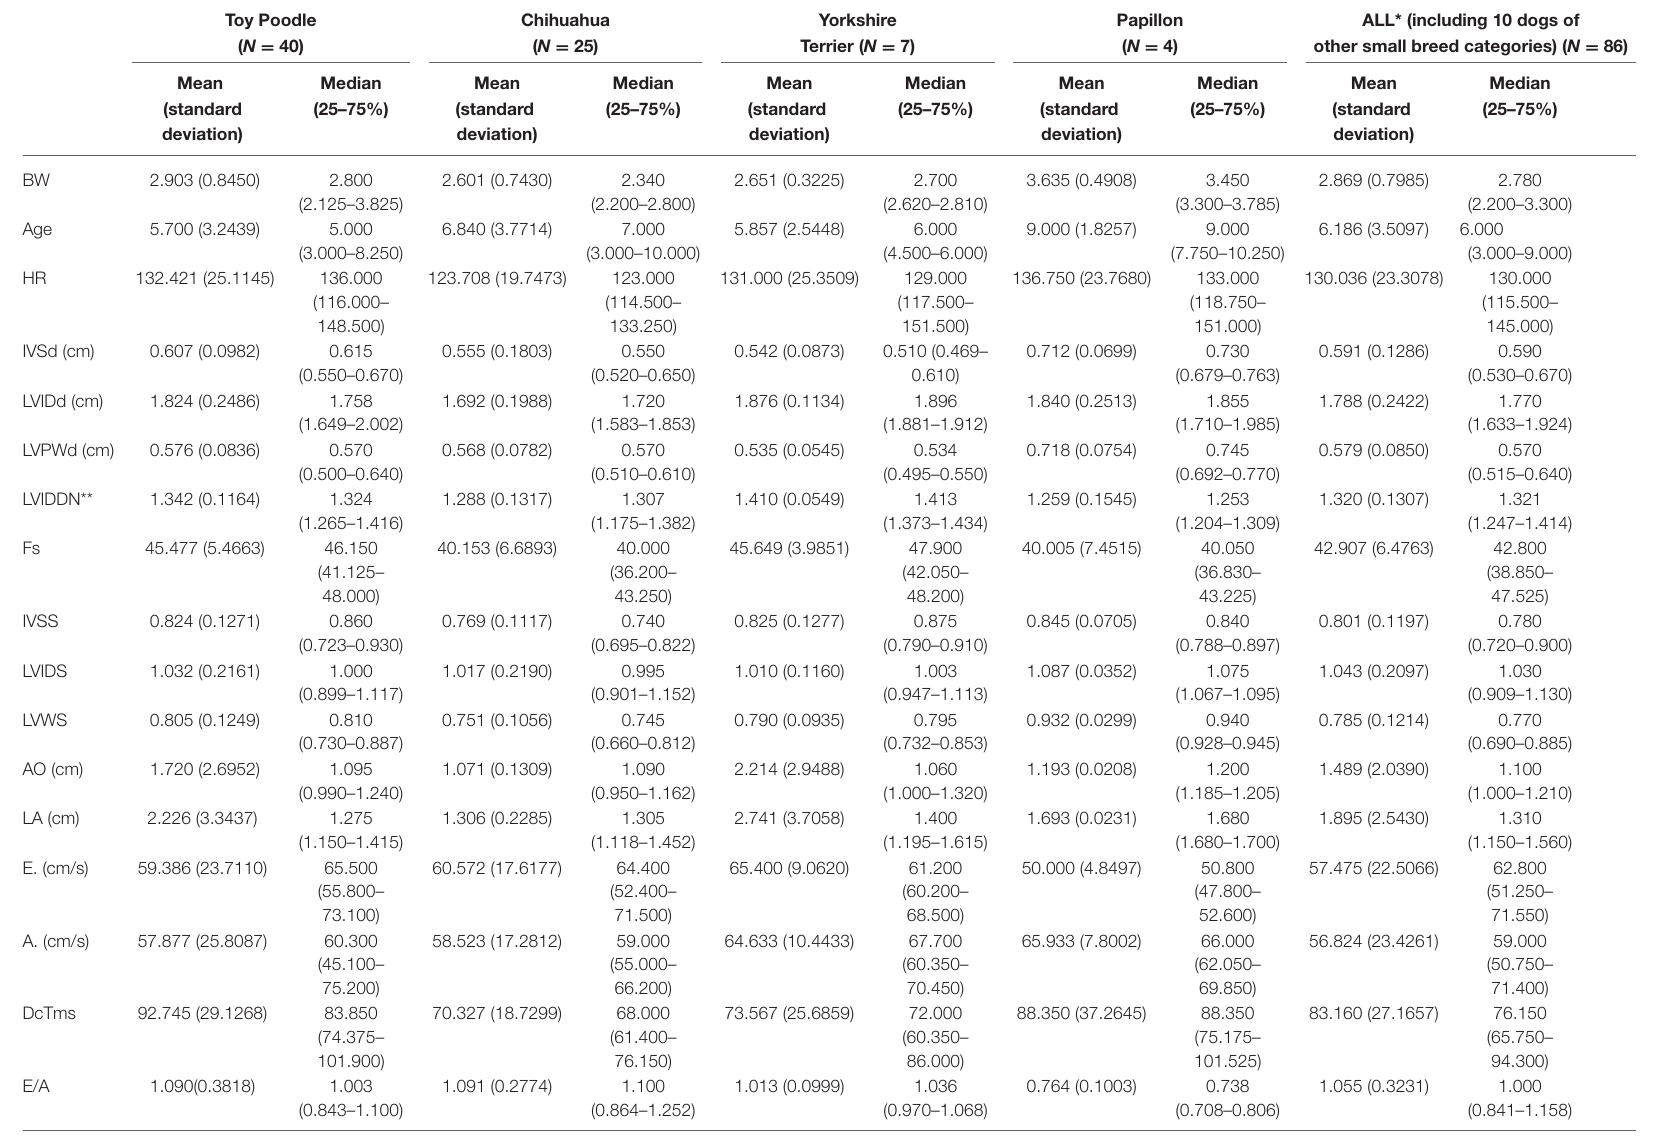
TABLE 1 | Calculation of basic statistics of dogs used in the